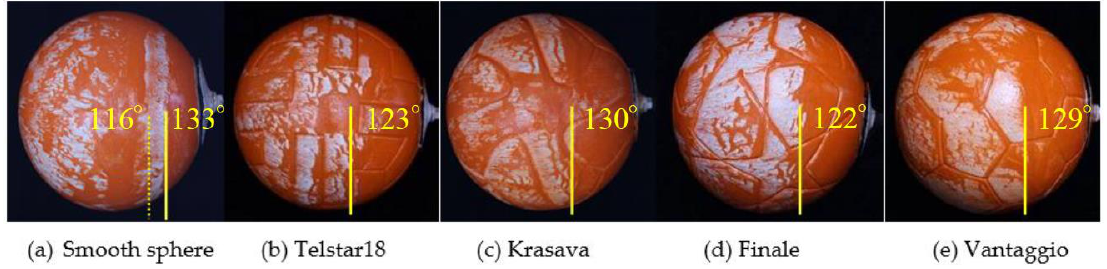
Figure 14. The results of the oil film experiment to show the separation point on the panels.